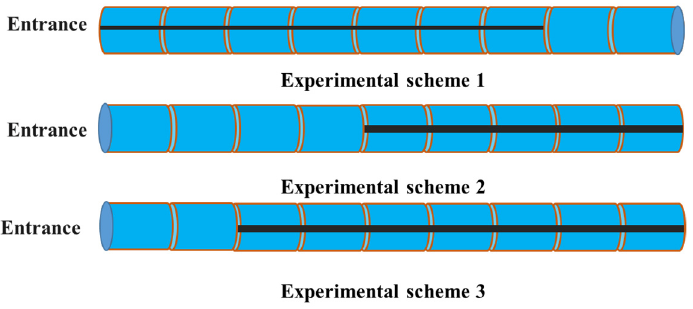
Figure 2. Schematic diagram of different crack test schemes.